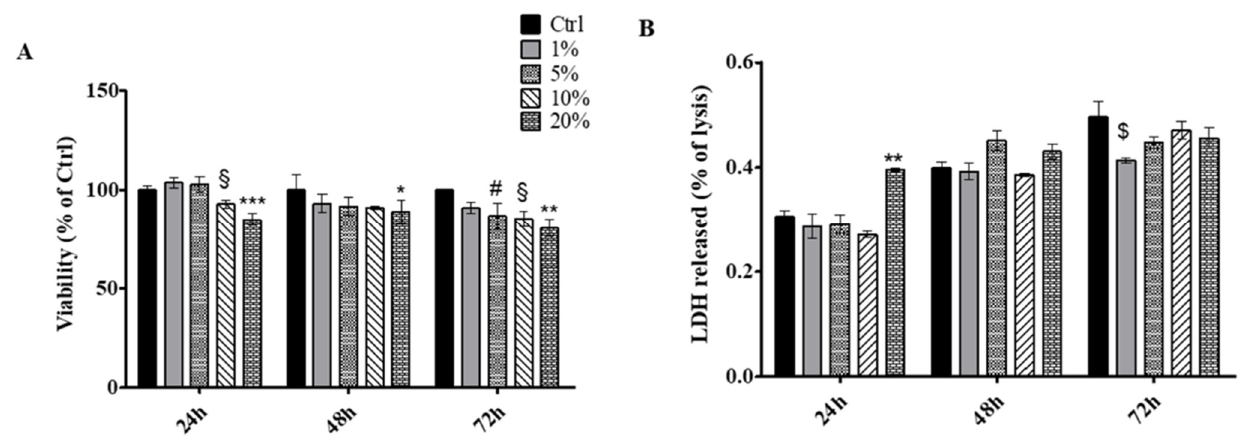
Figure 8. ( A ) MTT assay performed on HGFs treated for 24 h, 48 h and 72 h with SWLs in per-centages ranging from 1 to 20%. Metabolic activity was normalized to control cells treated with DMEM culture medium. The most representative of three separate experiments is shown. Data are presented as the mean ± standard deviation. § vs. Ctrl 24 h p < 0.01, *** vs. Ctrl 24 h p < 0.0001, * vs. Ctrl 48 h p < 0.001, #, § vs. Ctrl 72 h p < 0.01, ** vs. Ctrl 72 h p < 0.001. ( B ) LDH release from HGFs treated for 24 and 48 h with SWLs in percentages ranging from 1 to 20% 24 h and 48 h after treatment with wine lees. The most representative of three separate experiments is shown. Data are presented as the mean ± standard deviation. ** vs Ctrl 24 h p < 0.001, $ vs. Ctrl 48 h p < 0.01.